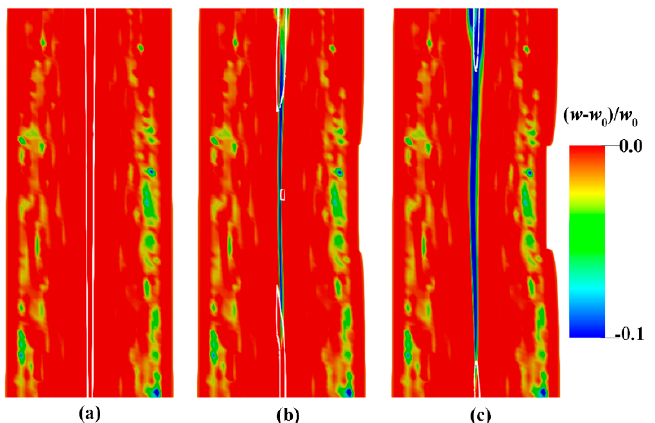
Figure 9. The distribution of the relative concentration of C at the punching region of the ingot at di ff erent times after punching starts: ( a ) 1 s, ( b ) 3 s, ( c ) 5 s. The white line indicates the solid fraction contour line of 0.8.